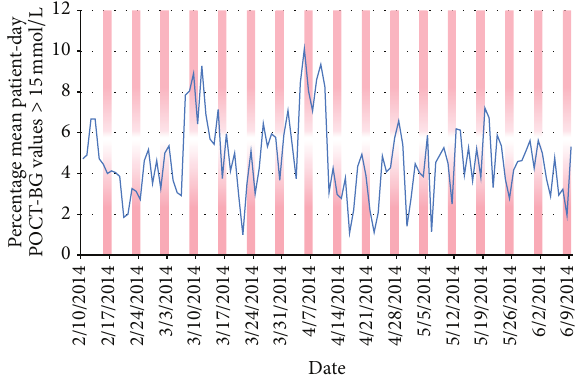
Figure 5: Line graph showing the number of POC-BG tests done by date in all ward locations analysed. Red area bars represent weekends.